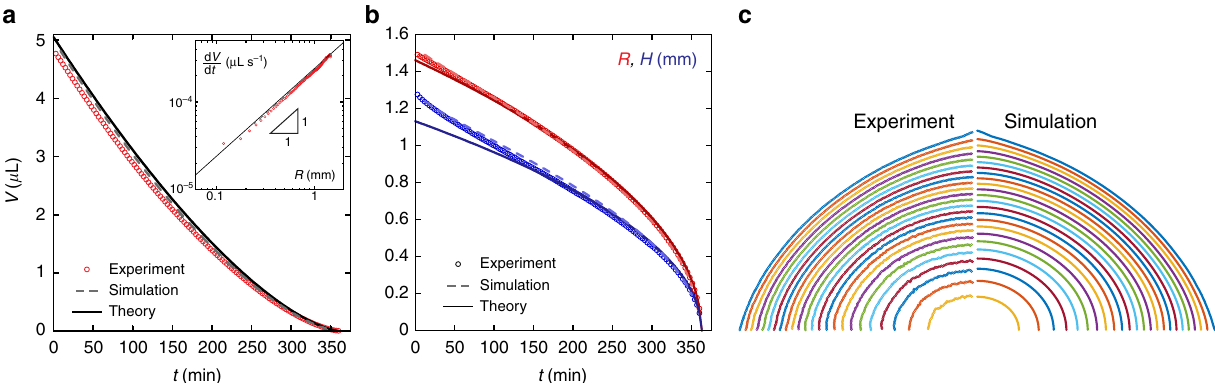
Fig. 5 Global ice drop evaporation. a Evolution of the volume V of the drop shown in Fig. 2; the inset shows the instantaneous volume fl ux d V /d t as a function of the drop radius. b radius R (red circles) and height H (blue circles) for the same drop. The dashed and solid lines denote the numerical simulation and analytical results, respectively (see Supplementary Note 2). c Experimental and numerical pro fi les taken every 15 min for the same drop